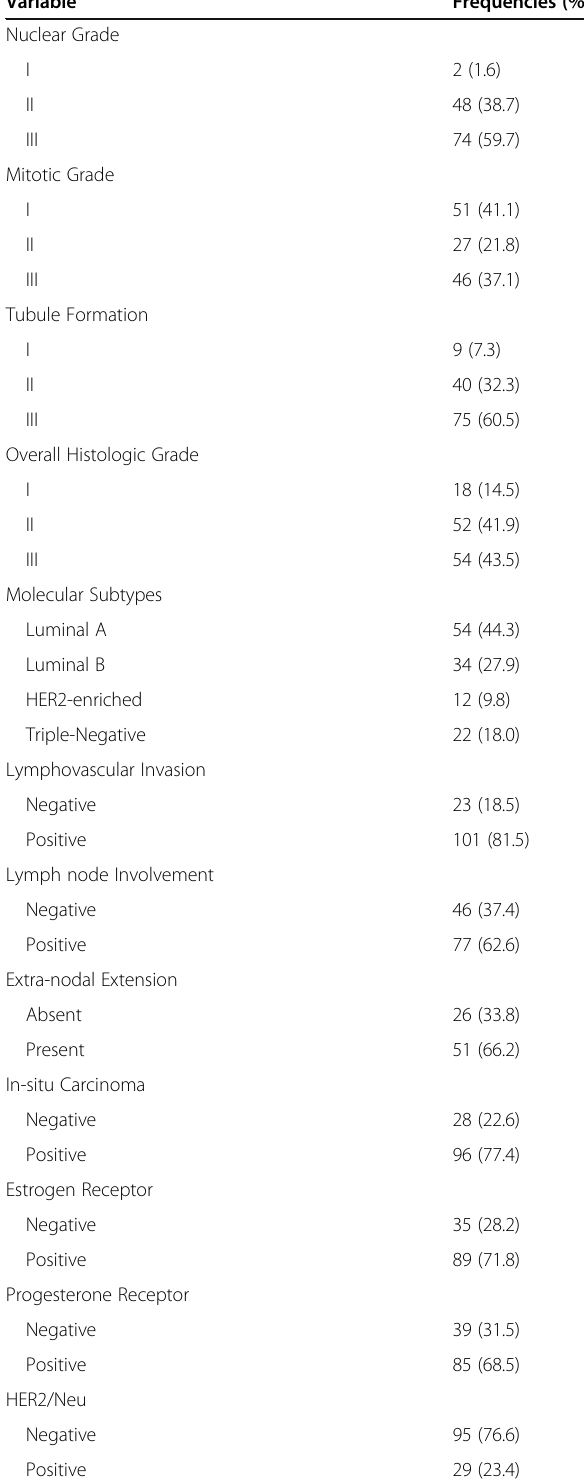
Table 1 Histopathologic descriptions of tumoral specimens